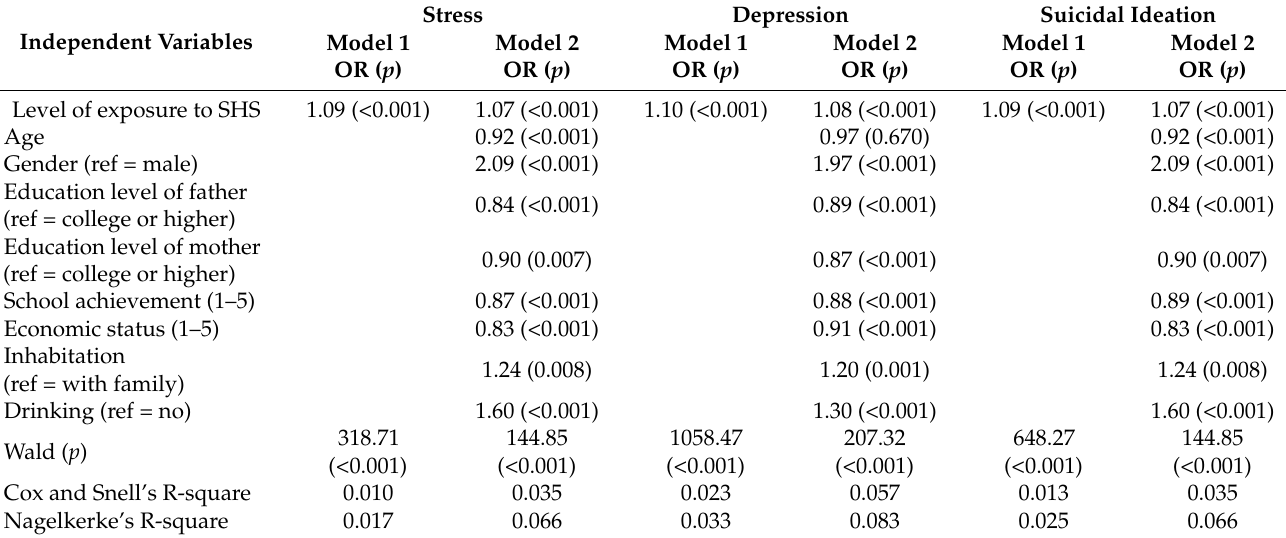
Table 2. Association between level of exposure to secondhand smoke and stress, depression, and suicidal ideation.